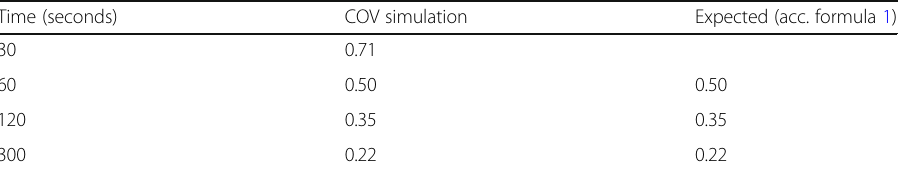
Table 1 The change of COV over different scan durations for the OSEM + PSF reconstruction, compared with the expected value, calculated based on the COV value at 30 s